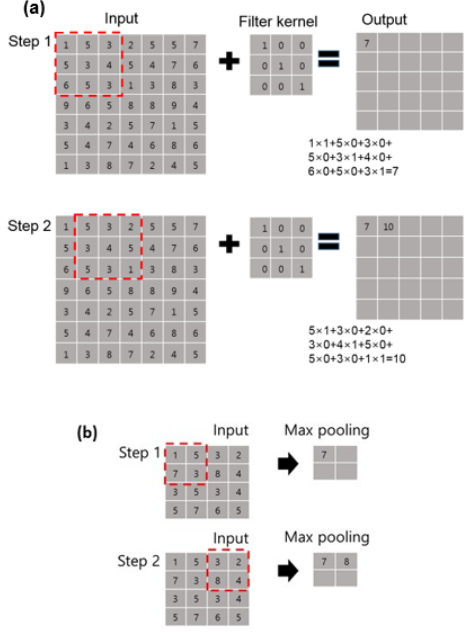
Figure 2. A schematic of convolution and pooling processes in CNN: ( a ) convolution process and ( b ) max pooling